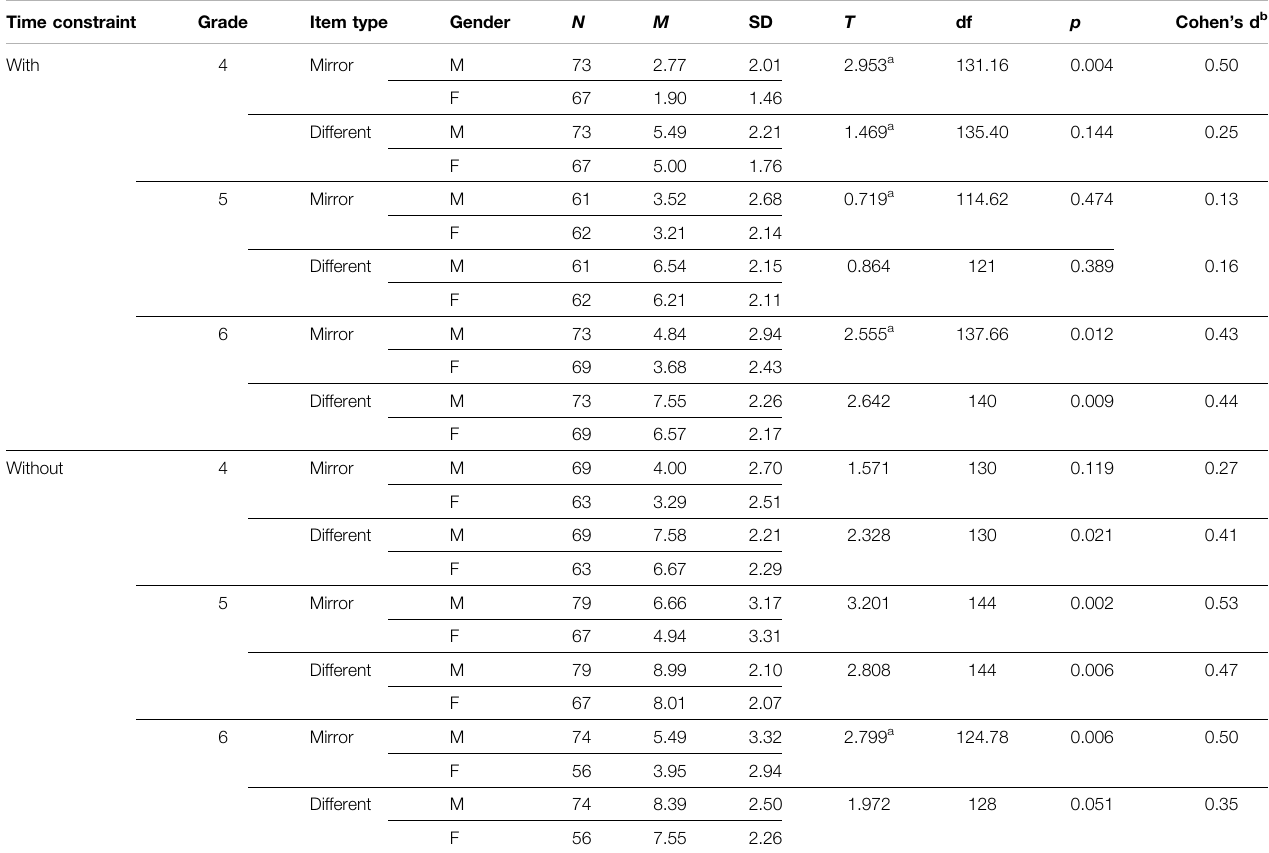
TABLE 6 | Gender differences by item type, grade, and time constraint. Time